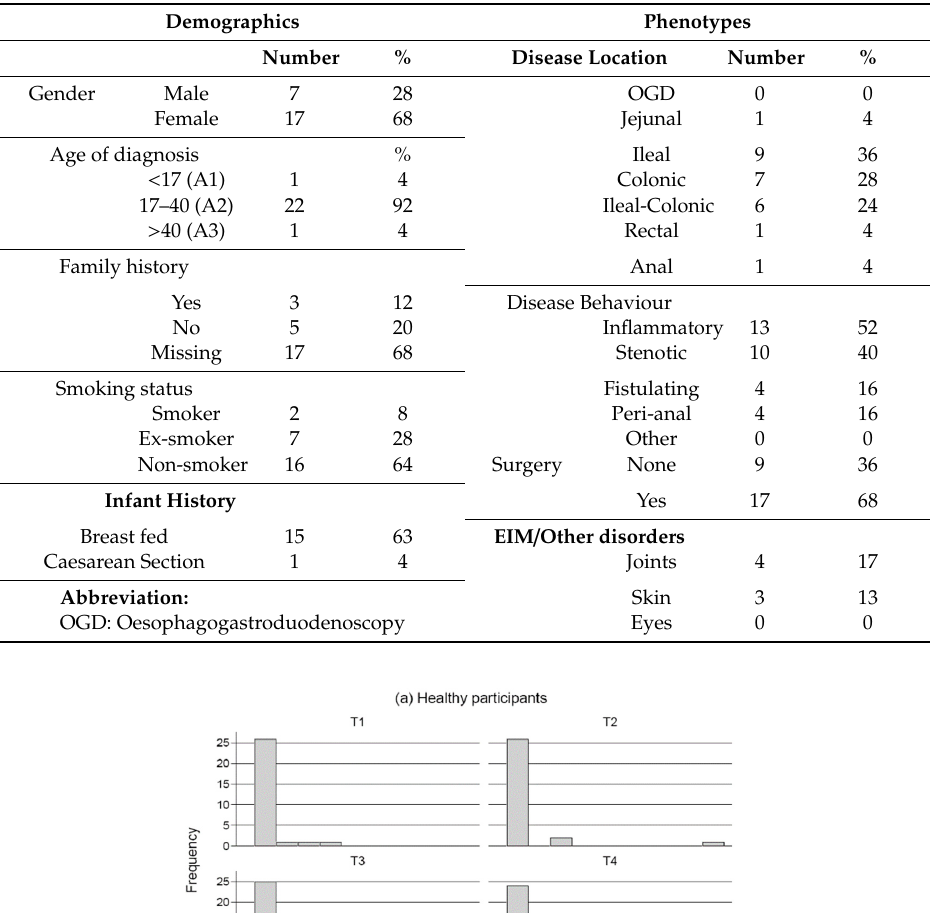
Table A1. Characteristics of the participants in the Crohn’s disease trial.